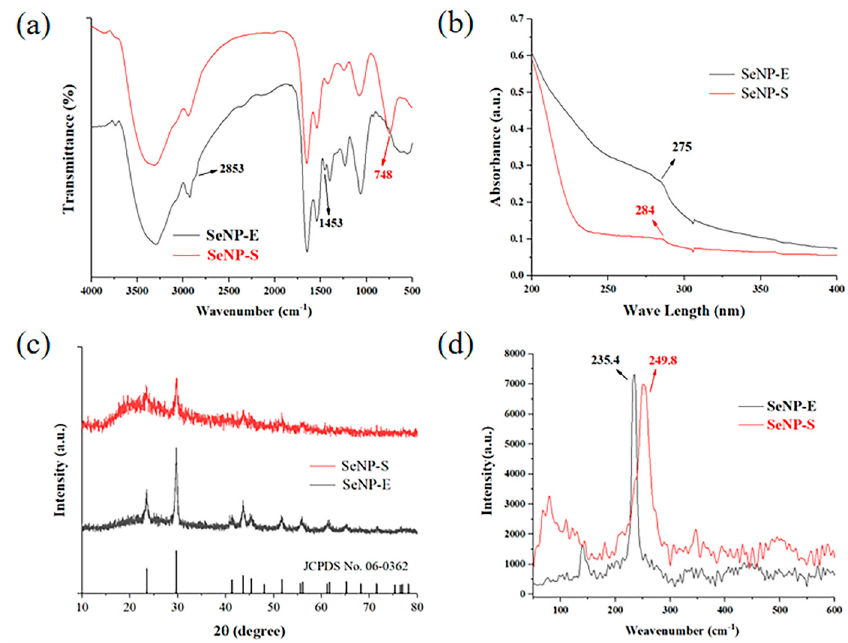
Figure 5. Spectroscopic characterization of SeNPs − E and SeNPs − S. ( a ) Infrared spectra. ( b ) UV spectra. ( c ) XRD diffraction patterns. ( d ) Raman spectra.